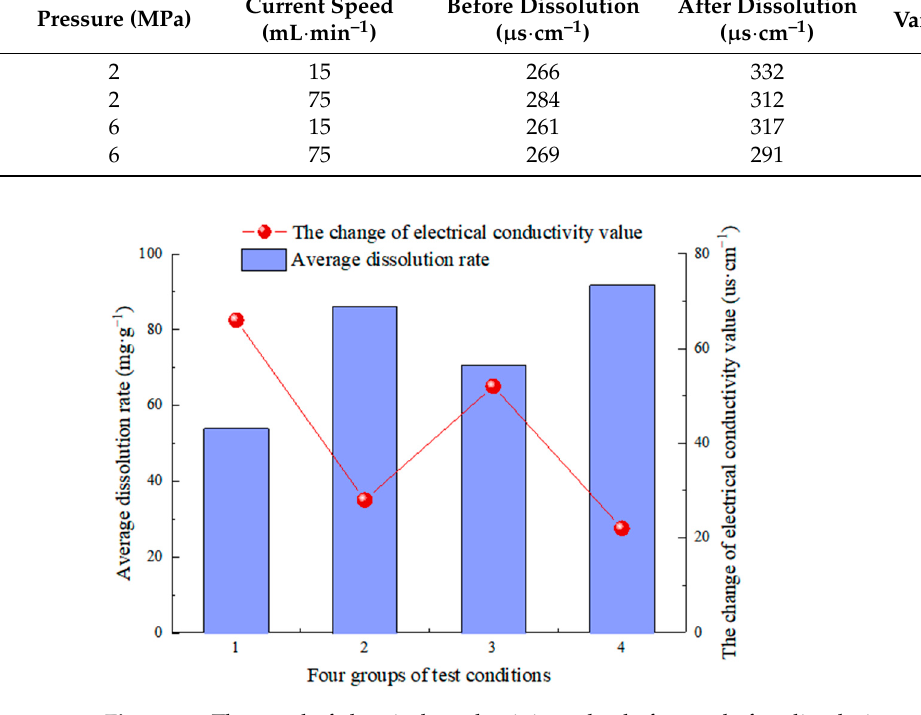
Figure 15. The trend of electrical conductivity value before and after dissolution.